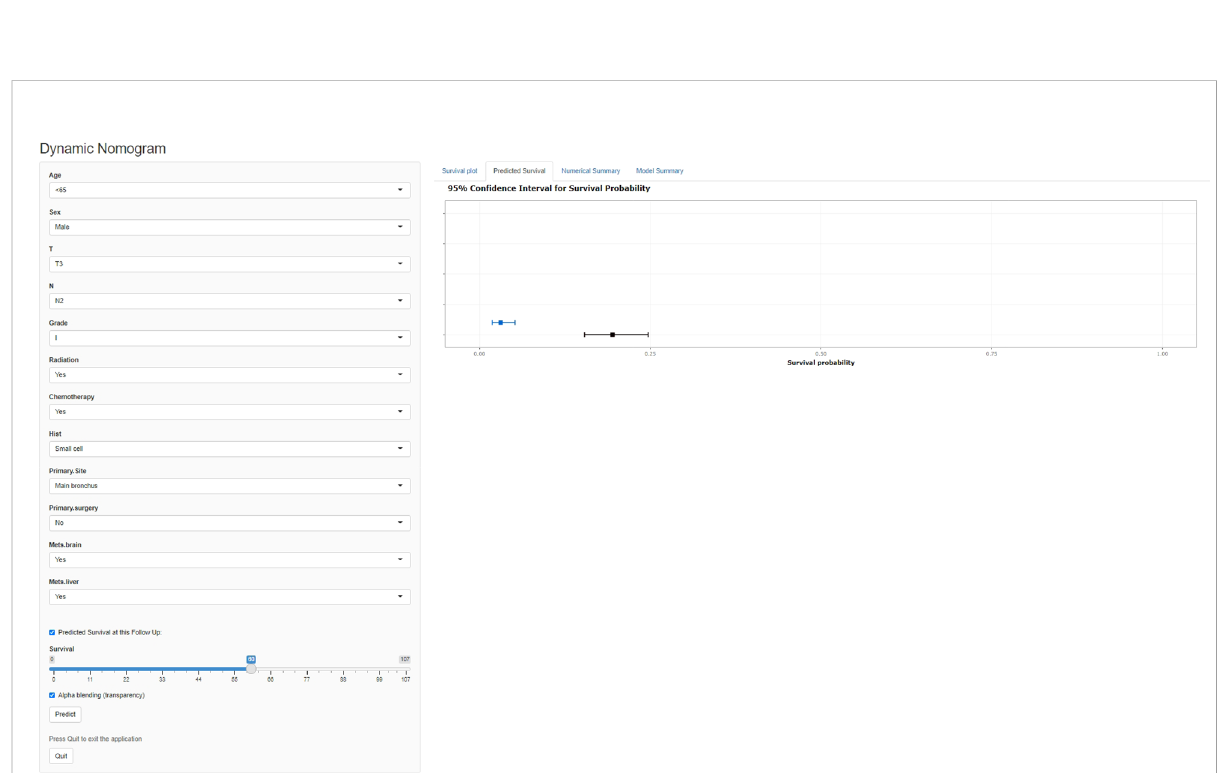
FIGURE 10 A web-based nomogram for predicting postoperative overall survival (OS). The line segments of the graphical summary show the approximate range of overall survival